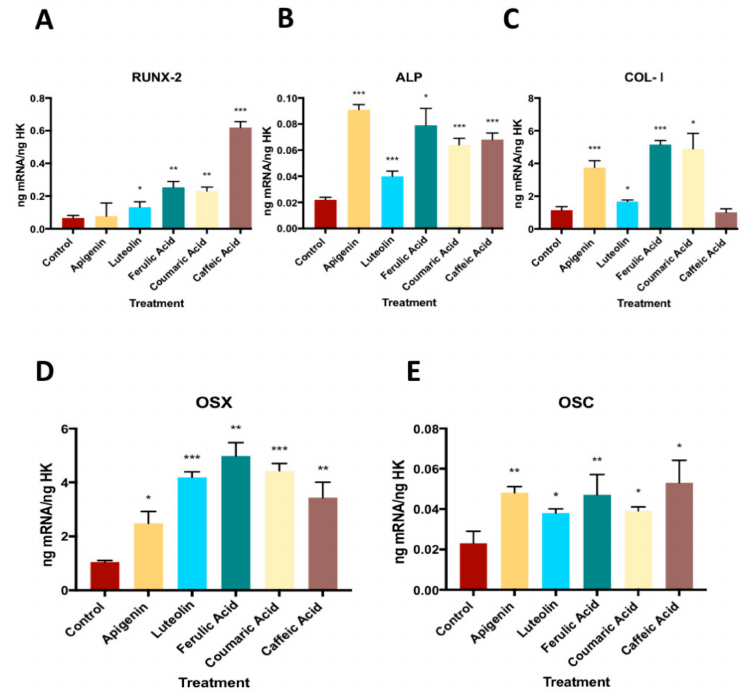
Figure 4. The e ff ect of phenolic compounds on the gene expression of RUNX-2, ALP, COL-I, OSX, and OSC. * p < 0.05, ** p < 0.005, *** p < 0.001. RUNX-2: Run-related transcription factor 2, ALP: Alkaline phosphatase, COl-I: Collagen type I, OSX: Osterix, OSC: